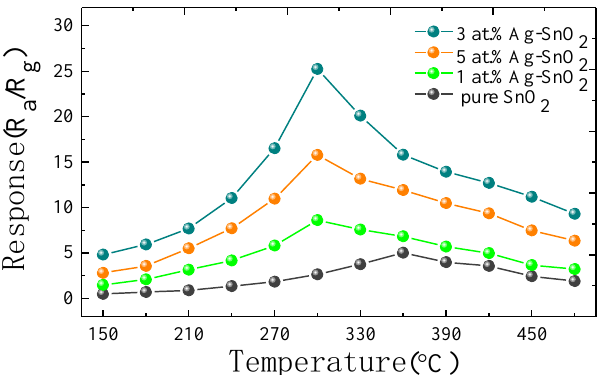
Figure 6. Gas responses of pure, 1 at.%, 3 at.% and 5 at.% Ag-doped SnO 2 based sensor to 50 μL/L H 2 at different working temperature.